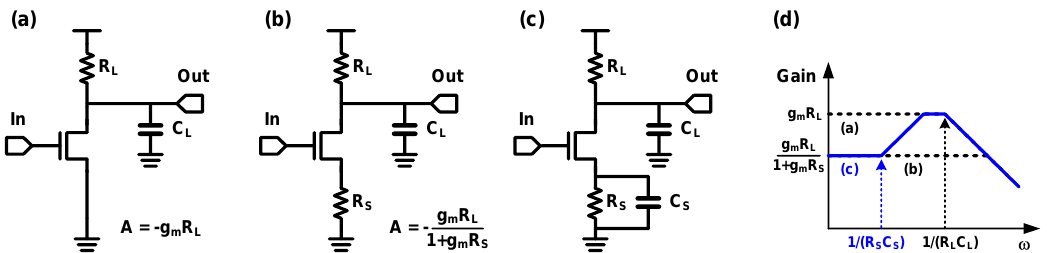
Figure 37. Summary of CTLE based on source degenerated CS stage. ( a – c ) Circuit diagrams of normal CS stage, CS stage with source degeneration resistor, and CS stage with source degeneration resistor and capacitor (CTLE). ( d ) Transfer function of CTLE.